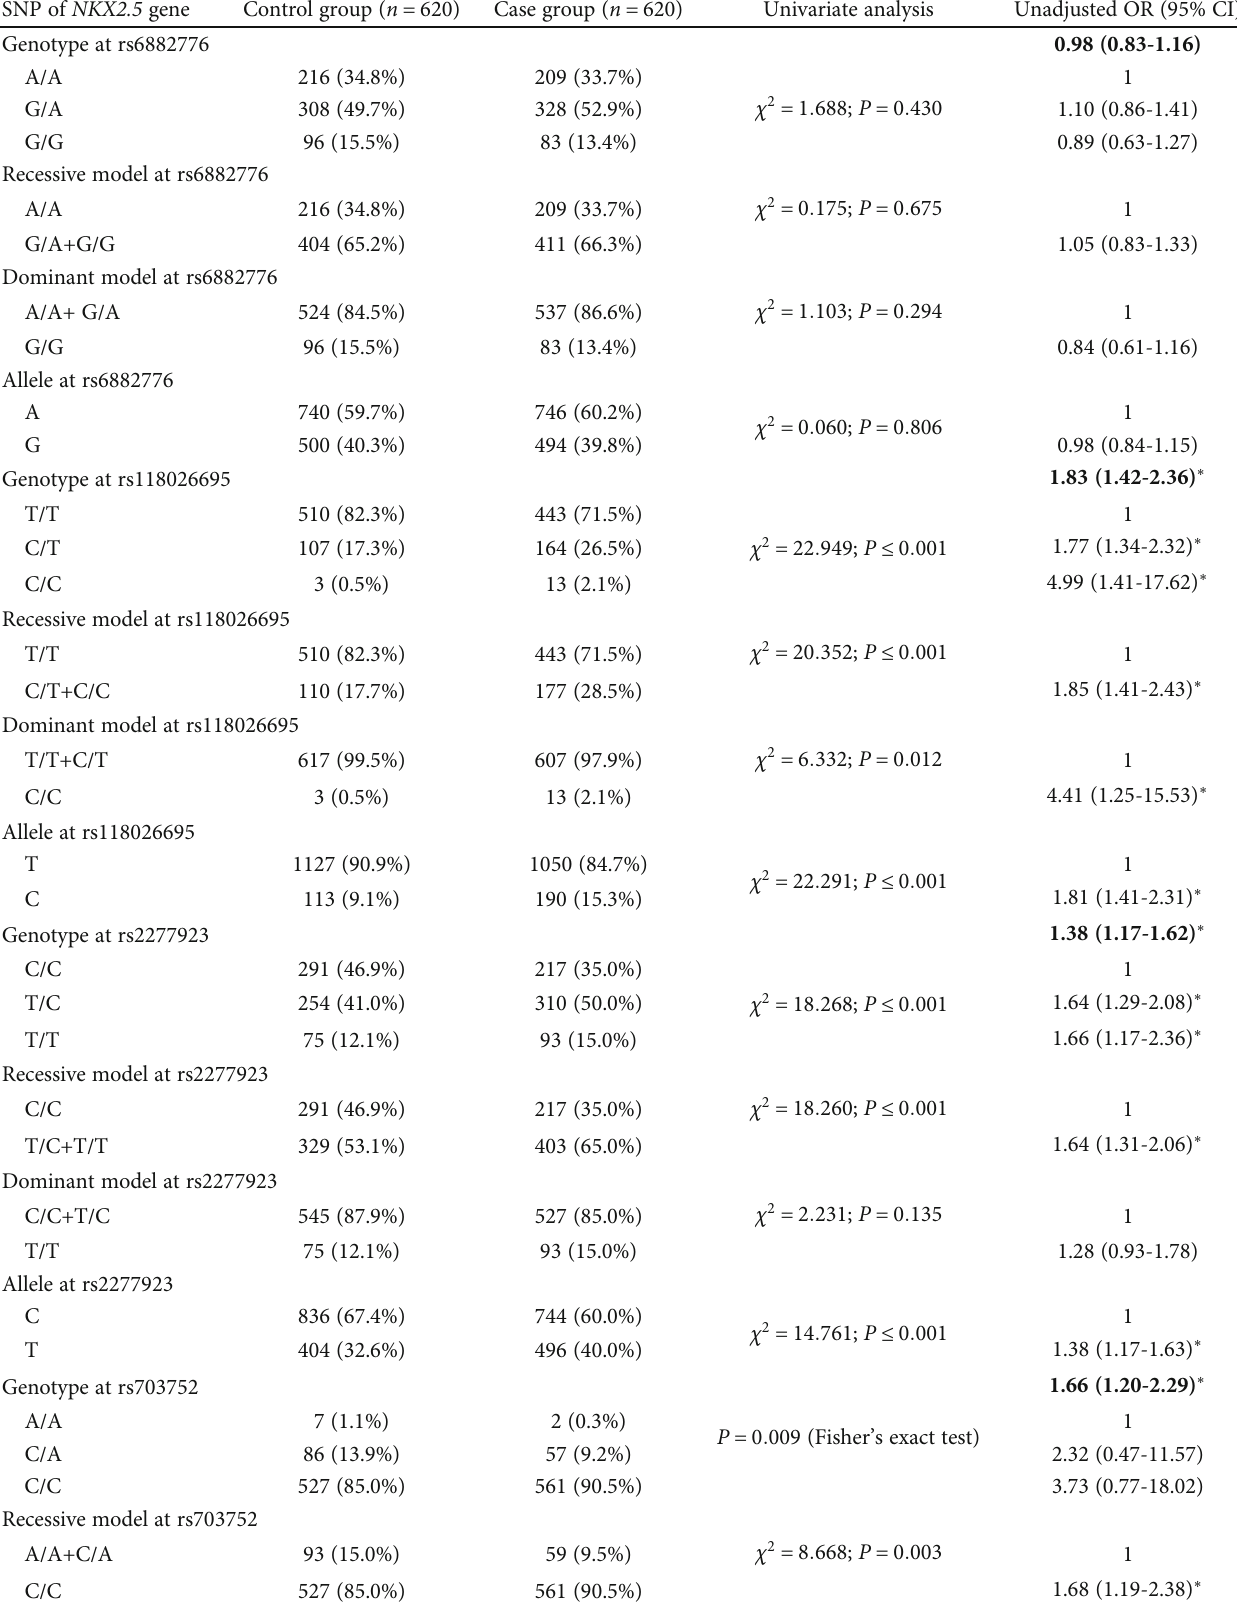
Table 4: Univariate analysis of NKX2.5 gene polymorphism and